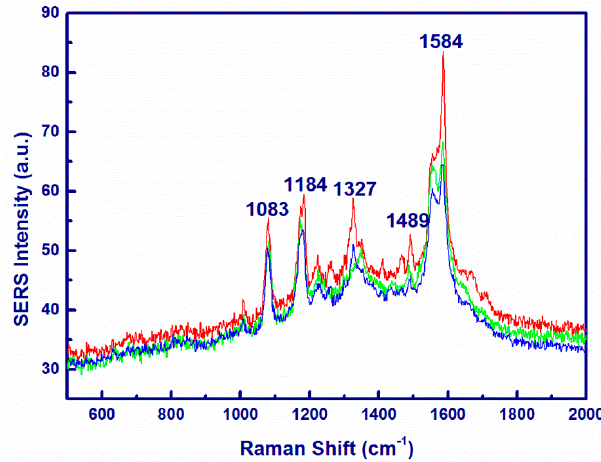
Figure 7. SERS spectrum of p-ATP (1 × 10 − 4 M) recorded on randomly selected three spots on the surface of